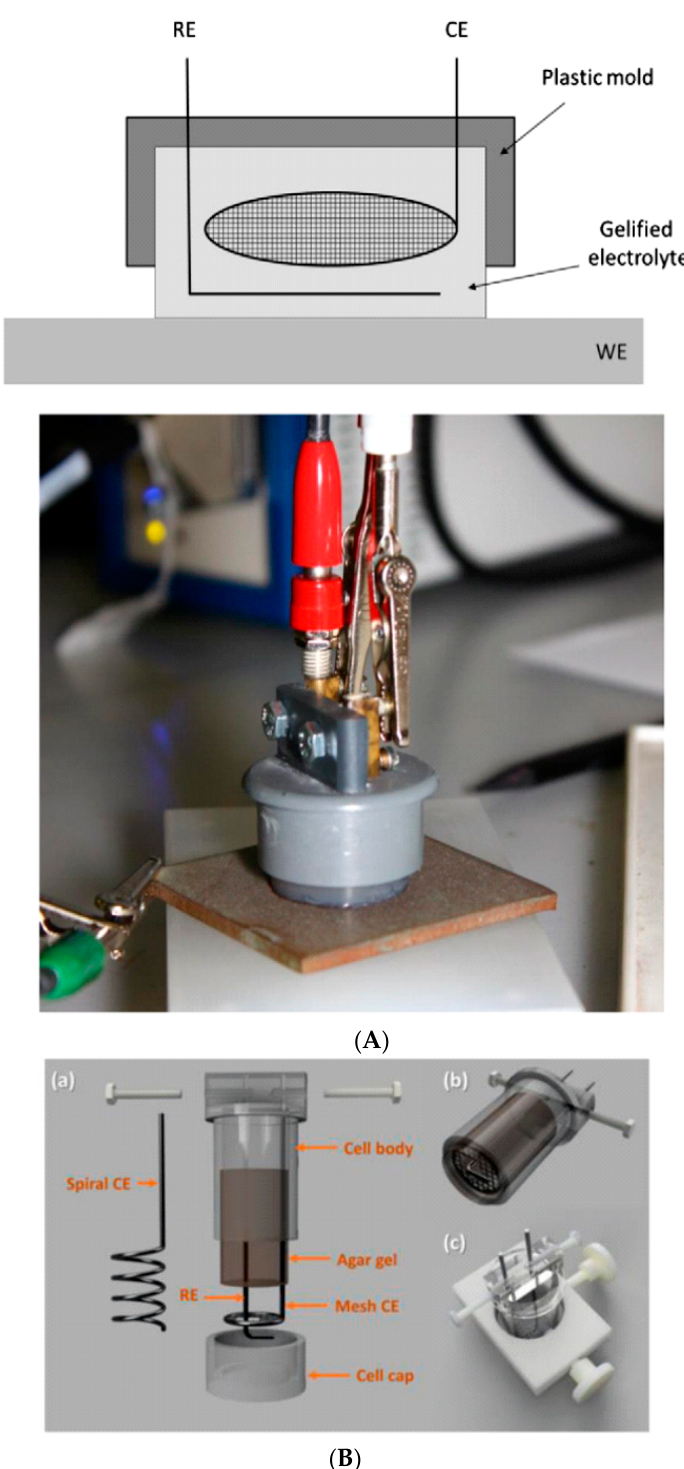
Figure 3. ( A ): Solid agarose gel electrolyte: scheme (up) and photograph (down); ( B ): zoom of a solid Figure 3. ( A ) Solid agarose gel electrolyte: scheme (up) and photograph (down); ( B ) zoom of a solid agarose gel. Reproduced and reprinted here with permission from [30] and [31], respectively agarose gel. Reproduced and reprinted here with permission from [31] and [50],